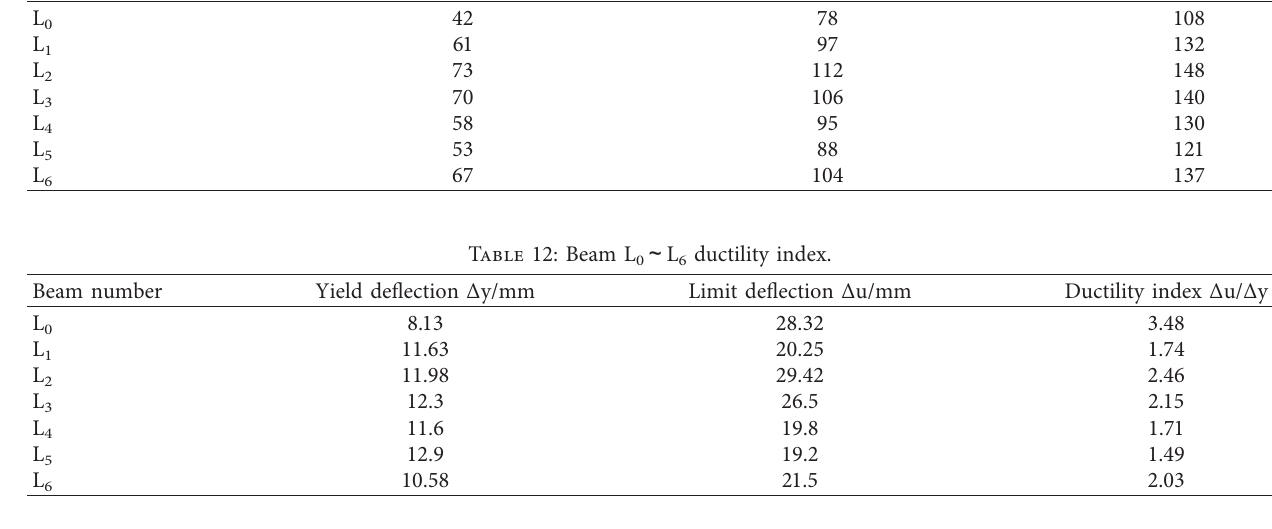
Table 11: Test value of the bearing capacity for each stage of beam L